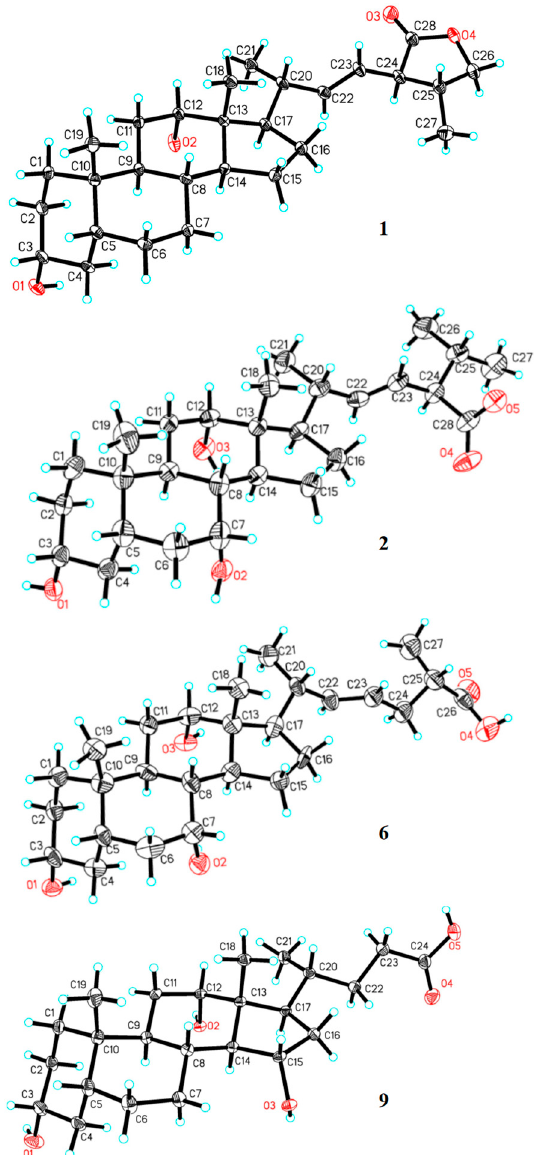
Figure 4. X-ray crystallographic structures of 1 , 2 , 6 , and 9 . Displacement ellipsoids of the non- hydrogen atoms are shown at 50% probability level. Hydrogen atoms are shown as blue spheres of arbitrary size. Oxygen atoms are shown in